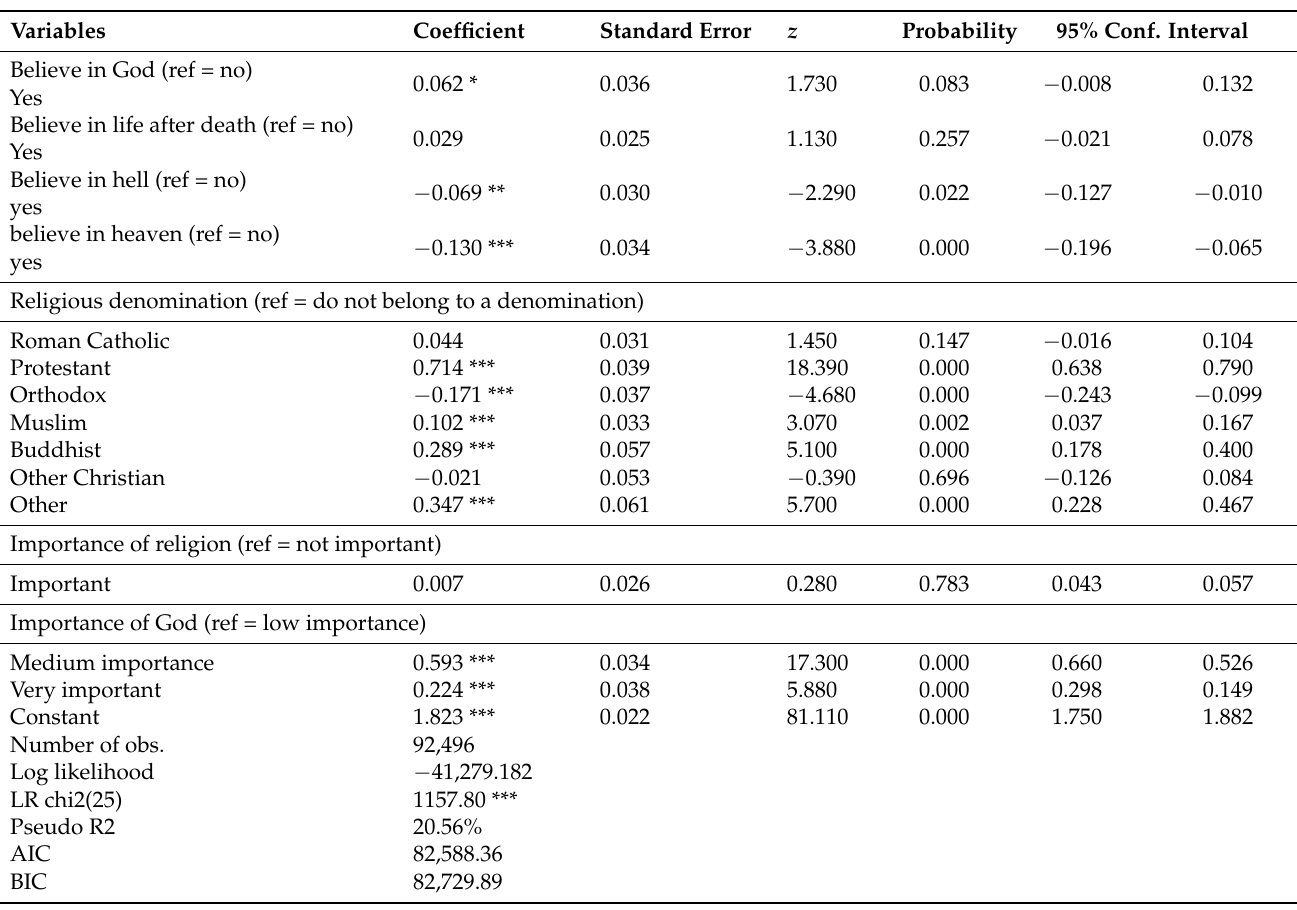
Figure 4. Heat map of the features selected and their importance in explaining the behaviour of tax morality. Table 3. The empirical results of tax morality logistic regression model based on chi-squared method of variable